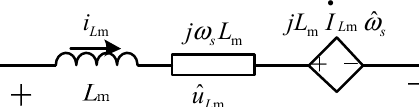
Figure 9. Small signal model of excitation inductance.